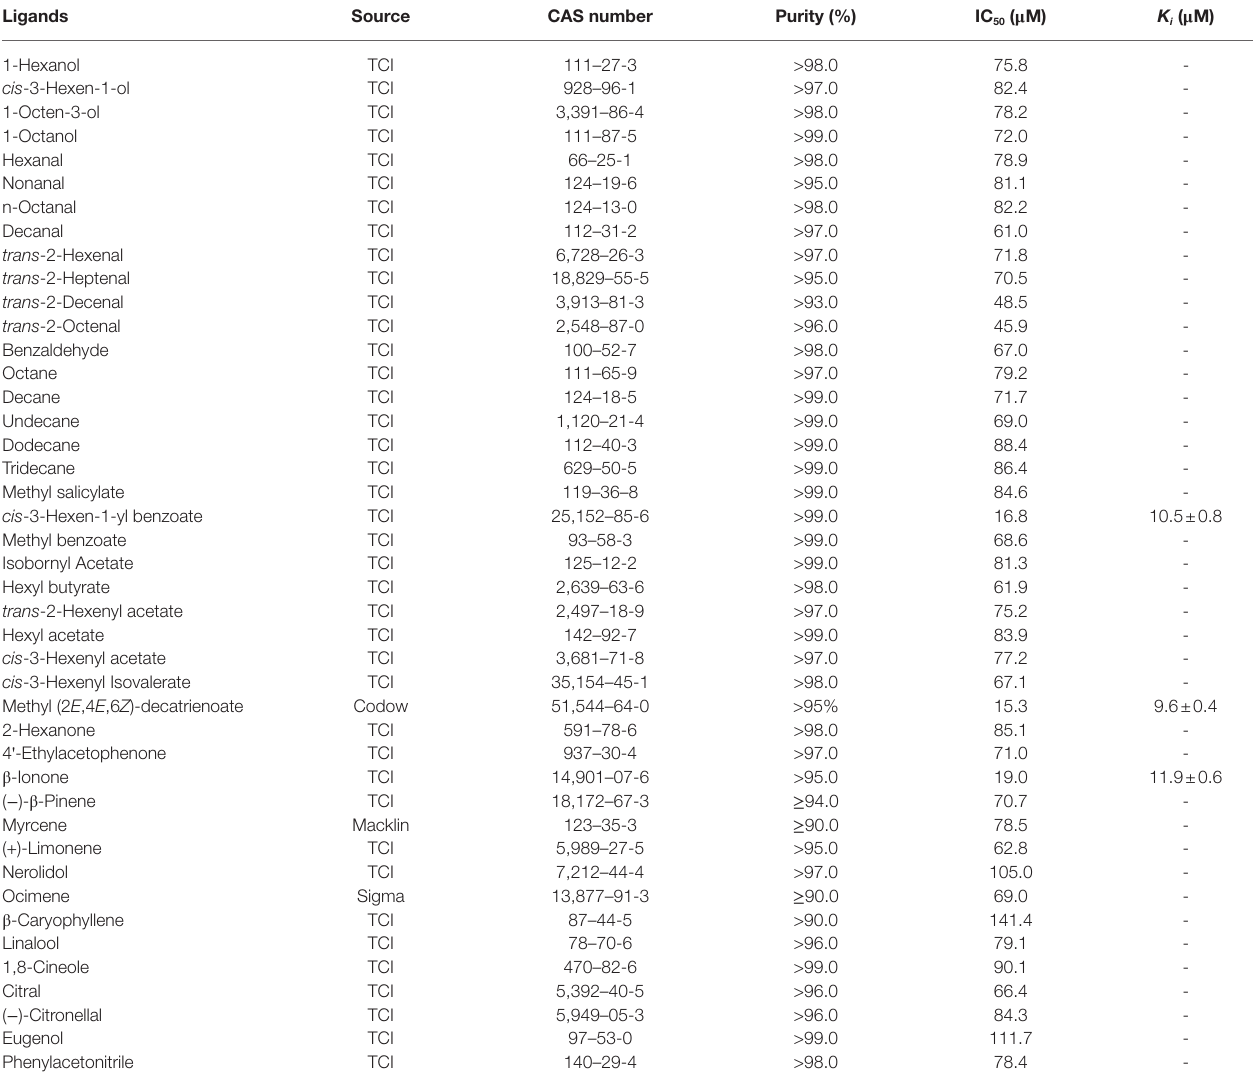
TABLE 1 | Binding affinities of all tested ligands to HhalCSP15. Ligands Source